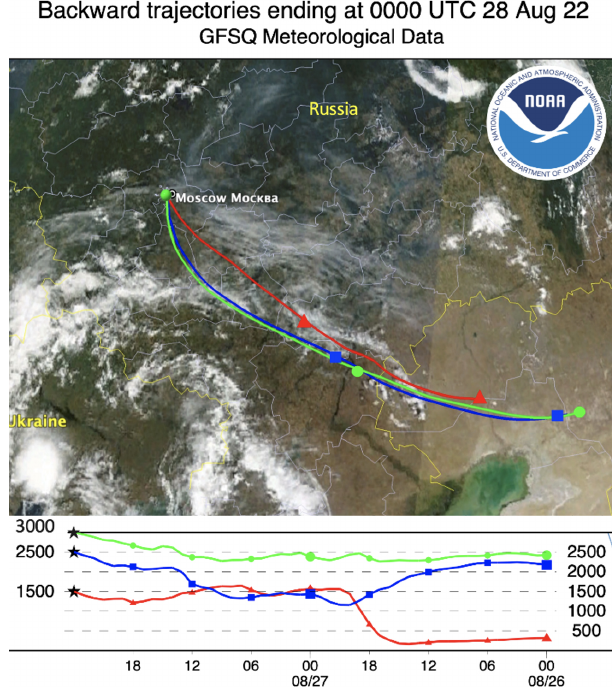
Figure 2. Backward trajectories of 2d from the NOAA HYSPLIT model for the air mass in Moscow on 28 August at 00:00UTC. The basemap is the Earth’s true-color image observed by MODIS Terra for the same